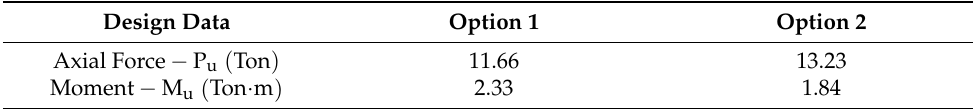
Table 3. Axial force and design moment for columns.